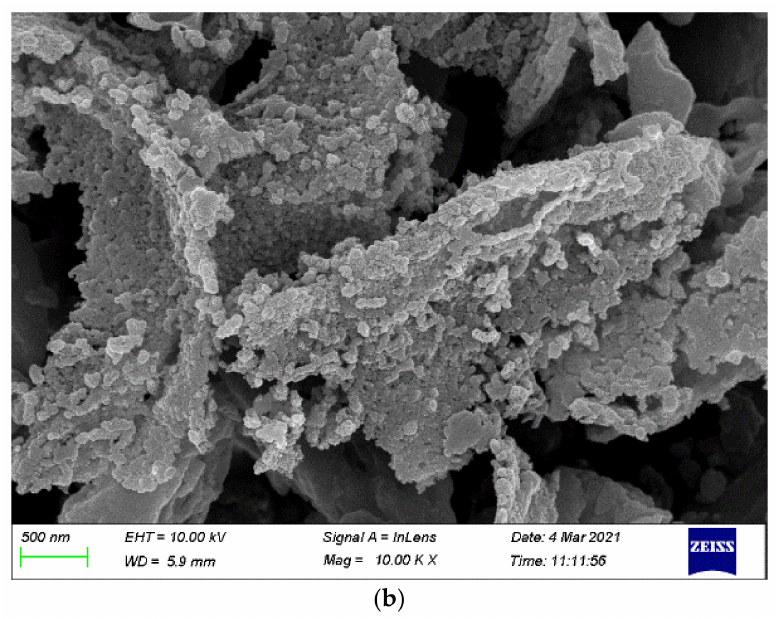
Figure 8. SEM images of 5% NH 3 -modified activated coke before and after adsorption of SO 2 and NO. ( a ) Before adsorption, ( b ) After adsorption.